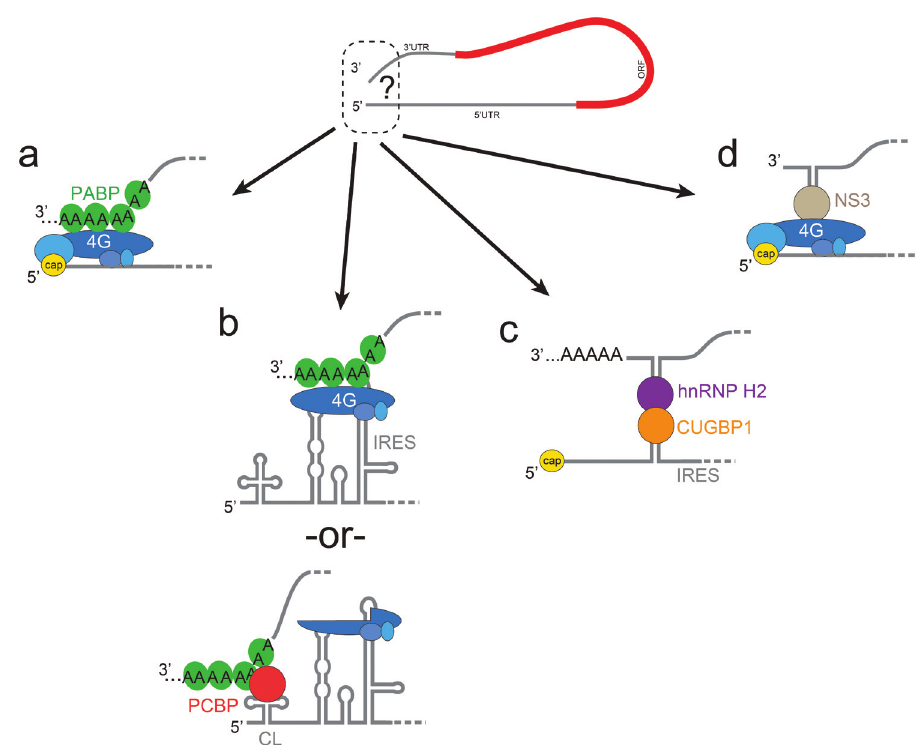
Figure 2. Diverse 5 ′ -to-3 ′ communication strategies. ( a ) The canonical eIF4G-PABP interaction, shown as in Figure 1b. ( b ) Two potential strategies used by poliovirus. ( c ) Strategy used by the serine hydroxymethyltransferase 1 IRES-containing mRNA. ( d ) Strategy used by rotavirus. CL, cloverleaf; CUGBP1, CUG-binding protein 1; hnRNP H2, heterogeneous nuclear ribonucleoprotein H2; IRES, internal ribosome entry site; NS3, non-structural protein 3; ORF, open reading frame; PABP, polyadenylate-binding protein; PCBP, poly(rC)-binding